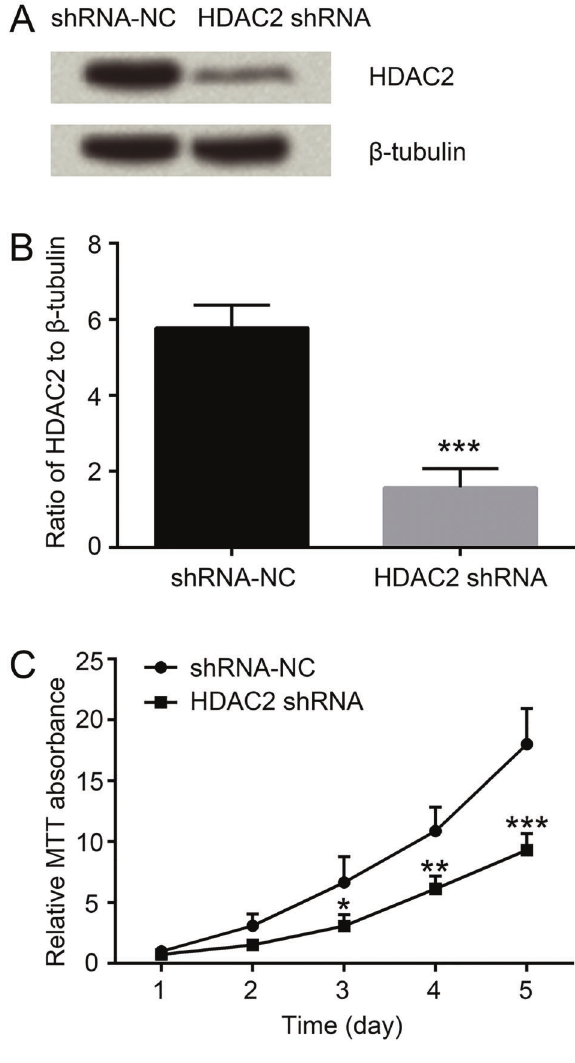
Figure 2. Knockdown of HDAC2 reduced cell viability in HCT116 cells. Cells were infected with shRNA-NC or HDAC2 shRNA. A and B , Protein expression of HDAC2 in infected cells. C , Cell viability of infected cells. Data are reported as the mean ± SD of 3 independent experiments. *P o 0.05; **P o 0.01; ***P o 0.001 (two-tailed unpaired t -test). HDAC2: histone deacetylase 2; HDAC2 shRNA: short hairpin RNA targeting HDAC2; shRNA-NC: negative control of HDAC2 shRNA; MTT: 3-(4,5-dimethylthiazol-2-yl)-2,5- diphenyltetrazolium